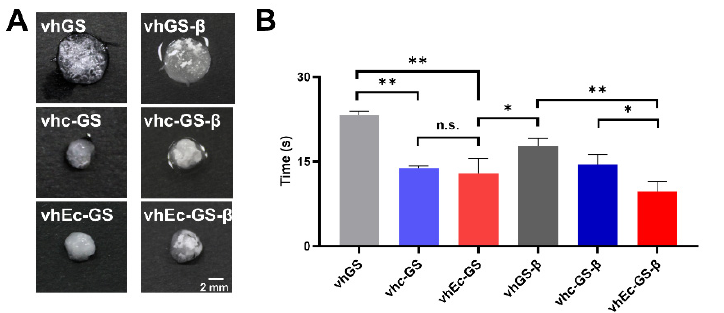
Figure 4. Hydrogel form and water absorption rate. ( A ) Form of hydrogel after the administration of ultrapure water to sponges. ( B ) Water absorption rate. * p < 0.05, ** p < 0.01. n.s.: not significant.